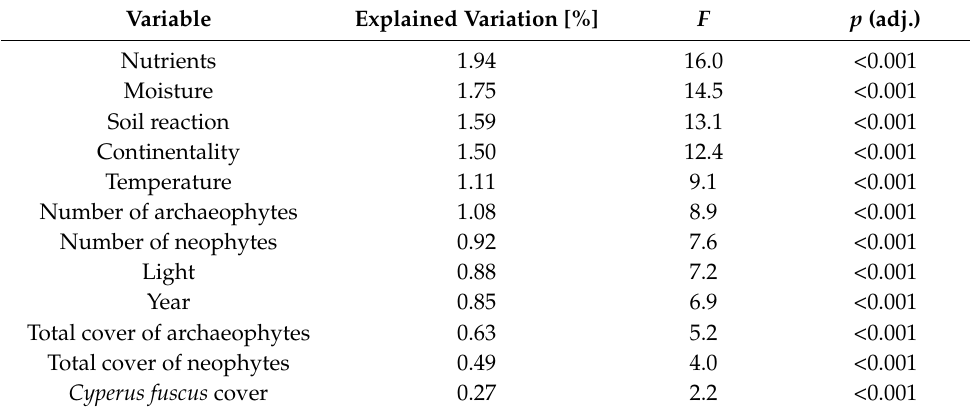
Table 2. Explanatory variables used in the canonical correspondence analysis (CCA) and their marginal effects. The p -values were adjusted using the false discovery rate. Environmental variables nutrients, moisture, soil reaction, continentality, temperature, and light correspond to relevant Ellenberg indicator